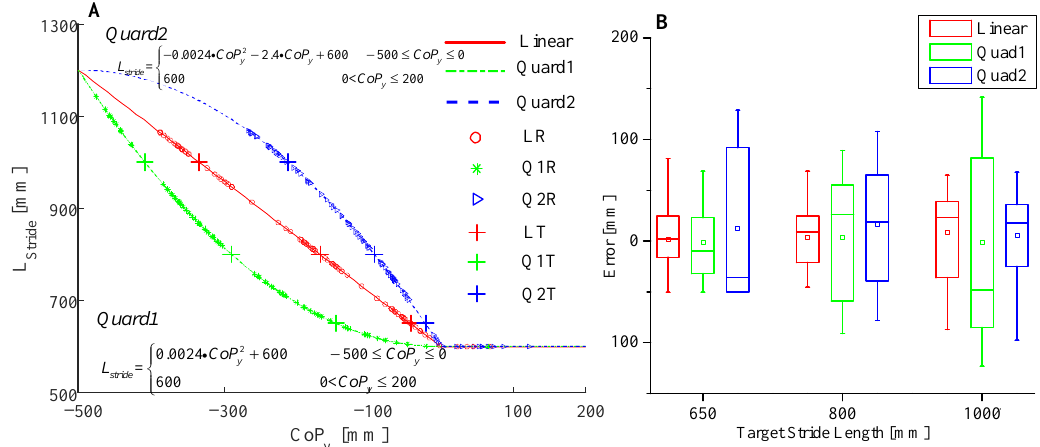
Figure 11. Stride length mapping function verification tests. ( A ) Walking test results with target stride lengths. “Linear” denotes the linear mapping function as shown in Equation (2), “Quad1” and “Quad2” are two quadratic functions for comparison. “LR”, “Q1R”, and “Q2R” are test results (the combined CoP and stride length) with the Linear, Quad1, and Quad2 mapping functions, respectively. “LT”, “Q1T”, and “Q2T” are the target stride lengths for the test with the Linear, Quad1, and Quad2 mapping functions, respectively. ( B ) Errors toward the target stride length of each test. For each mapping function of each target stride length, all 5 volunteers’ results were concerned.